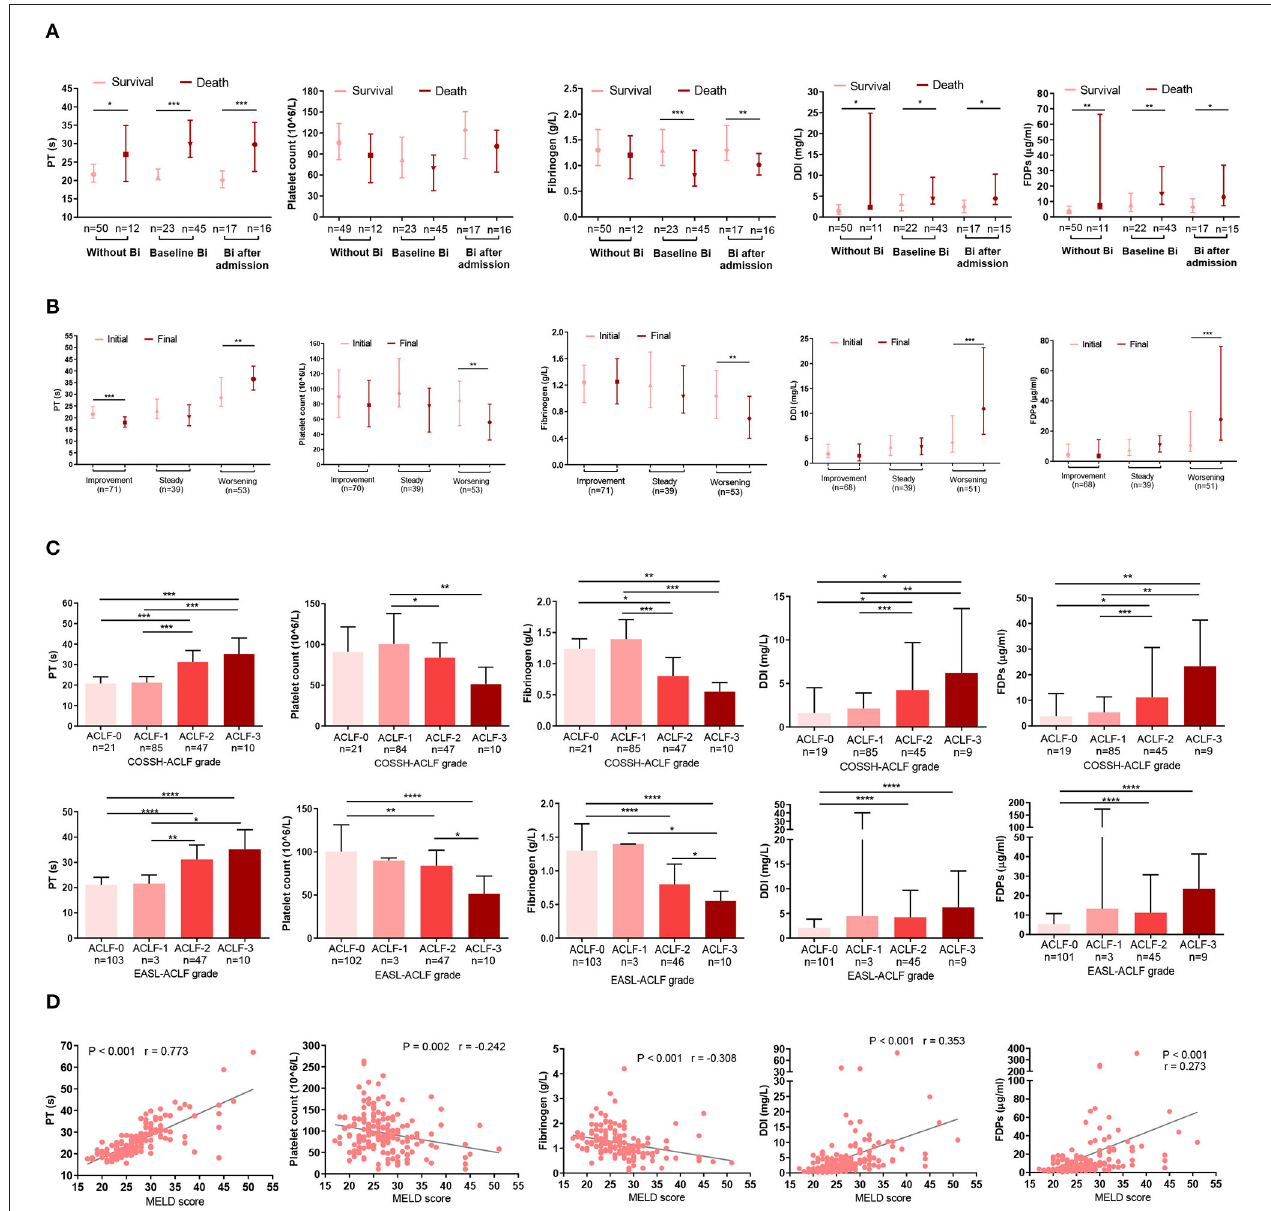
FIGURE 2 | Association between indicators in the DIC score system and prognosis. (A) The bar indicates the mode of DIC score indicators (platelet count, PT, DDI, FDPs, and fibrinogen) in infected or non-infected HBV-ACLF patients who survived or died. Without Bi: patients who never had infection during the whole course within 90 days; baseline Bi: patients who had infection at baseline; Bi after admission: patients without infection at baseline and developed bacterial infection within 90 days. (B) Changes in DIC score indicators (platelet count, PT, DDI, FDPs, and fibrinogen) according to the clinical course. Initial: the parameters were detected at baseline; final: the parameters were detected at last within 28 days of diagnosis or before death or discharge from the hospital. (C) Association between DIC score indicators (platelet count, PT, DDI, FDPs, and fibrinogen) and COSSH-ACLF/EASL-ACLF grade. (D) Correlations between DIC score indicators (platelet count, PT, DDI, FDPs and fibrinogen) and MELD score. Platelet count was missing in one patient, and five patients lacked D-dimer and FDPs information. Some patients had been treated in other hospitals before being admitted to Huashan Hospital, so some had complications with Bi upon admission. DIC, disseminated intravascular coagulation; PT, prothrombin time; DDI, D-dimer; FDPs: fibrinogen degradation products; HBV-ACLF, hepatitis B virus-related acute-on-chronic liver failure; Bi, bacterial infection; COSSH-ACLF, Chinese Group on the Study of Severe Hepatitis B-acute-on-chronic liver failure; EASL-ACLF, European Association for the Study of the Liver-ACLF; MELD, Model for end-stage liver disease. * P < 0.05, ** P < 0.01, and *** P < 0.001.